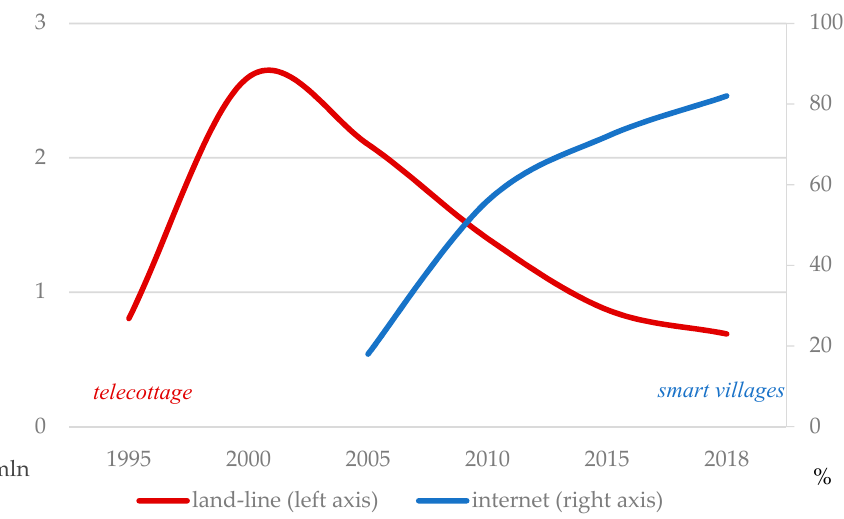
Figure 4. Rural land-line telephone subscribers and rural households with internet access. Source: own work based on BDL GUS data and [43,44] (p. 437, p. 327).